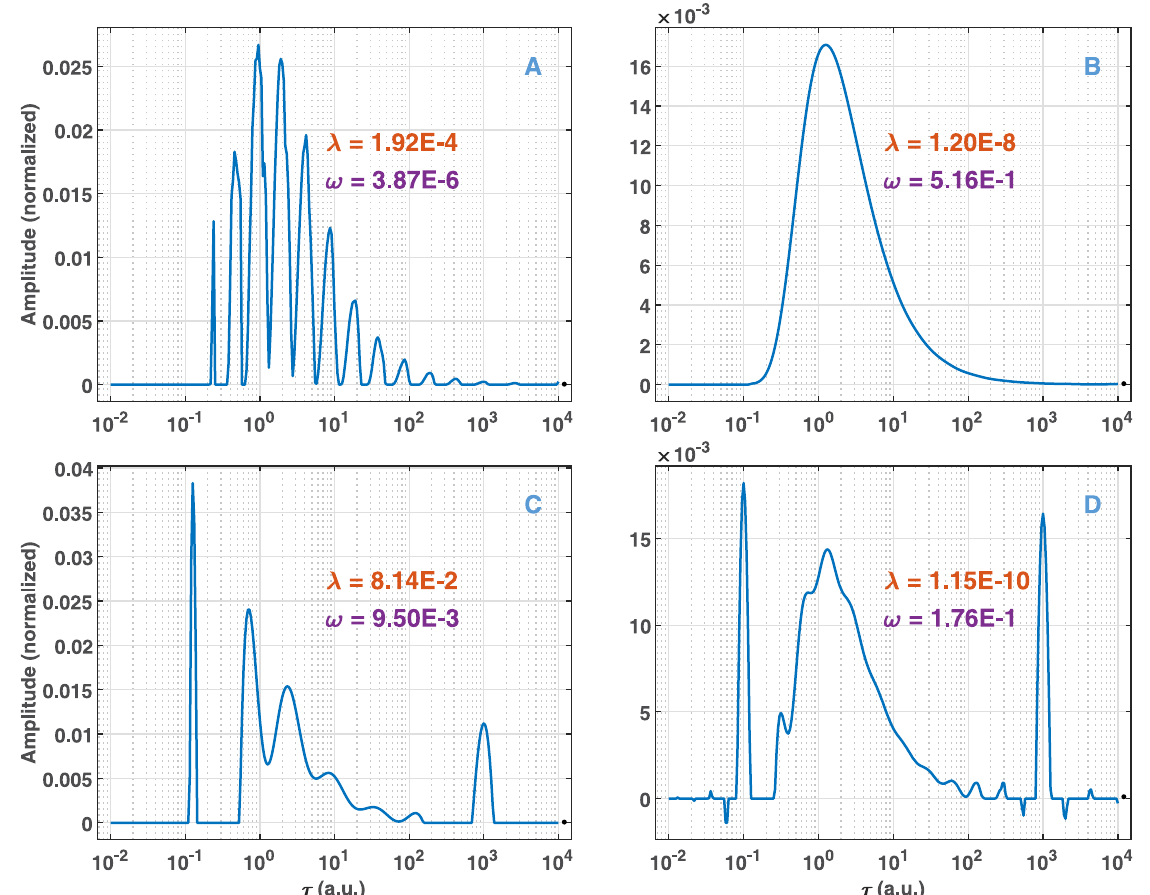
Fig 13. Solution of the GENP obtained from data described by formula (15) at low noise. For (A) and (C), the model selection was carried out by RCV( n v ), while for (B) and (D) by 10-fold CV. For (A) and (B), the value of A in the formula is 0, while for (C) and (D) its = 10 − 7 . λ and ω are the hyperparameters found by the BO value is 1. C = 8, τ 1 = 10 1 , τ 2 = 10 − 1 , τ 3 = 10 3 . Noise level: σ rel